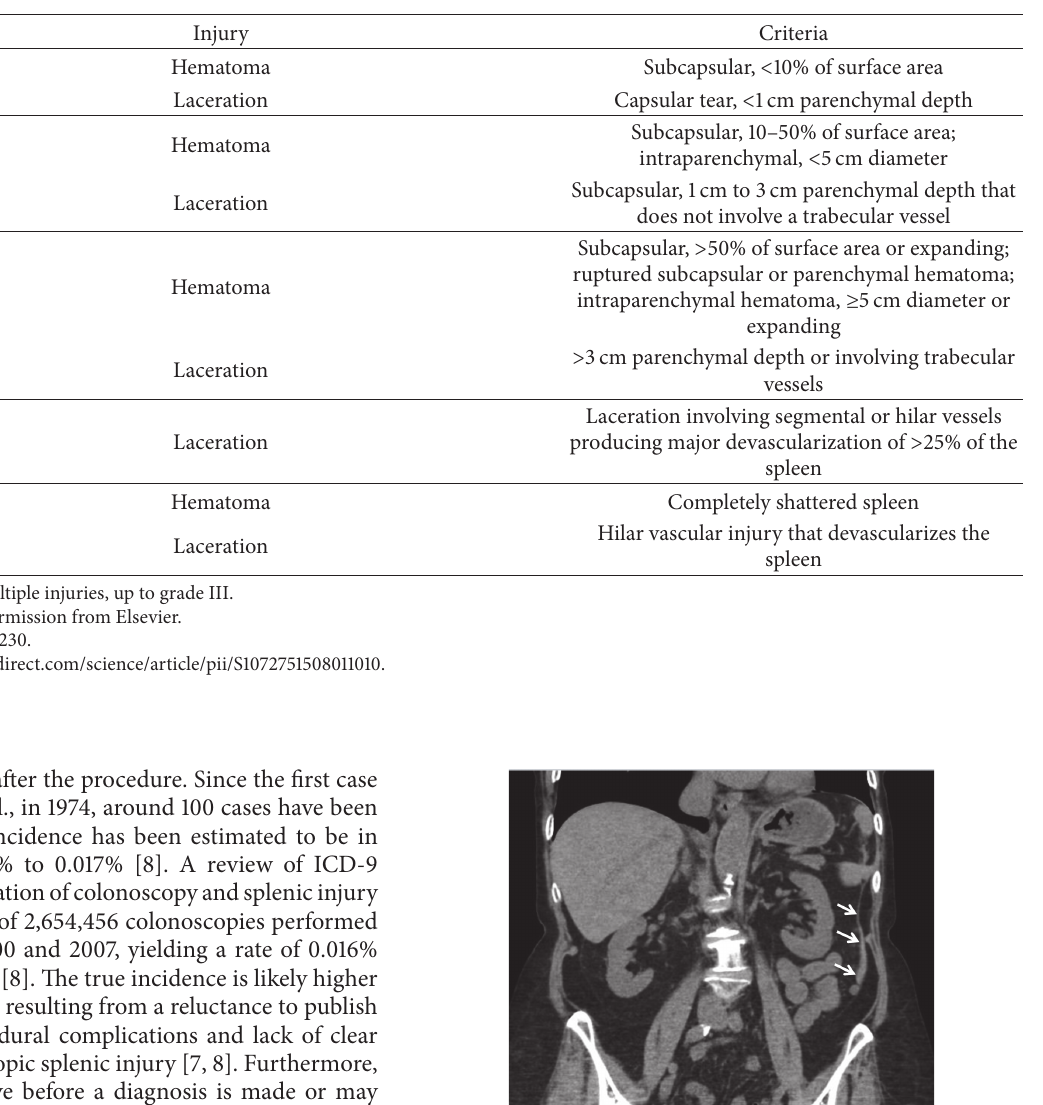
Table 1: The American Association of Surgeons for Trauma (AAST). Splenic Injury Grading Scale (2008).